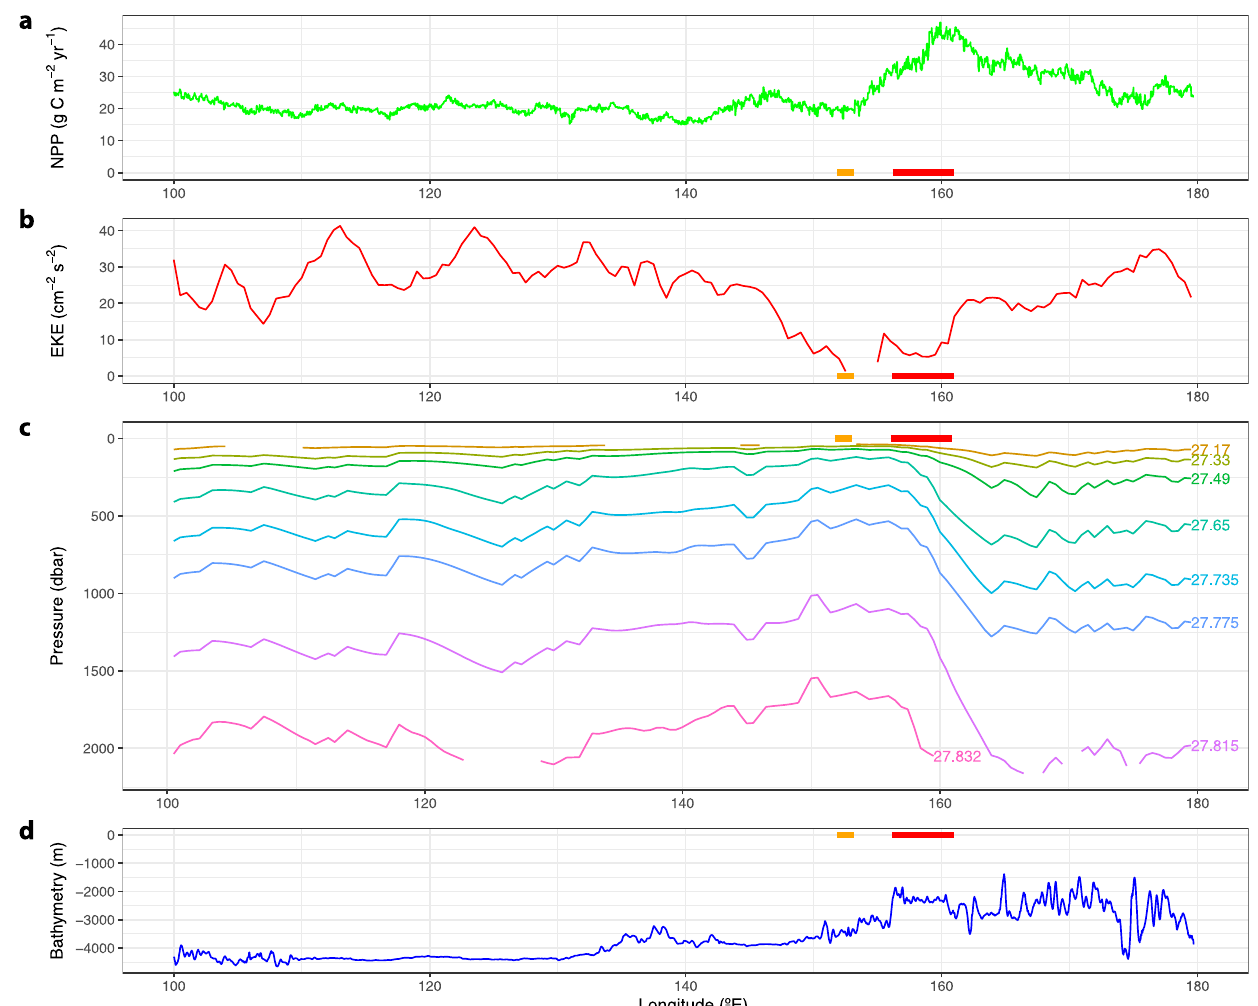
Fig. 4 Position of the bloom relative to factors that promote upwelling along the southern Antarctic Circumpolar (ACC) front (sACCf). a Net primary production (NPP), b eddy kinetic energy (EKE), c isopycnal pressure, and d bathymetry along the sACCf according to the front positions of Orsi et al. 35 . Supplementary Fig. 2 shows maps of the data used in this fi gure with the position of the sACCf. The longitudinal position of KR1 and KR2 are shown by the red line and orange line, respectively, on each panel. Bathymetry data are from